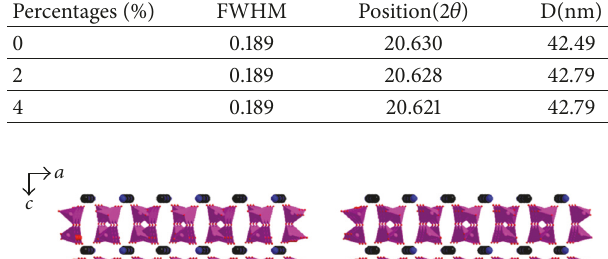
Eu (PO 3 ) 4 ( x=0, 0.02 and 0.04). x - x )